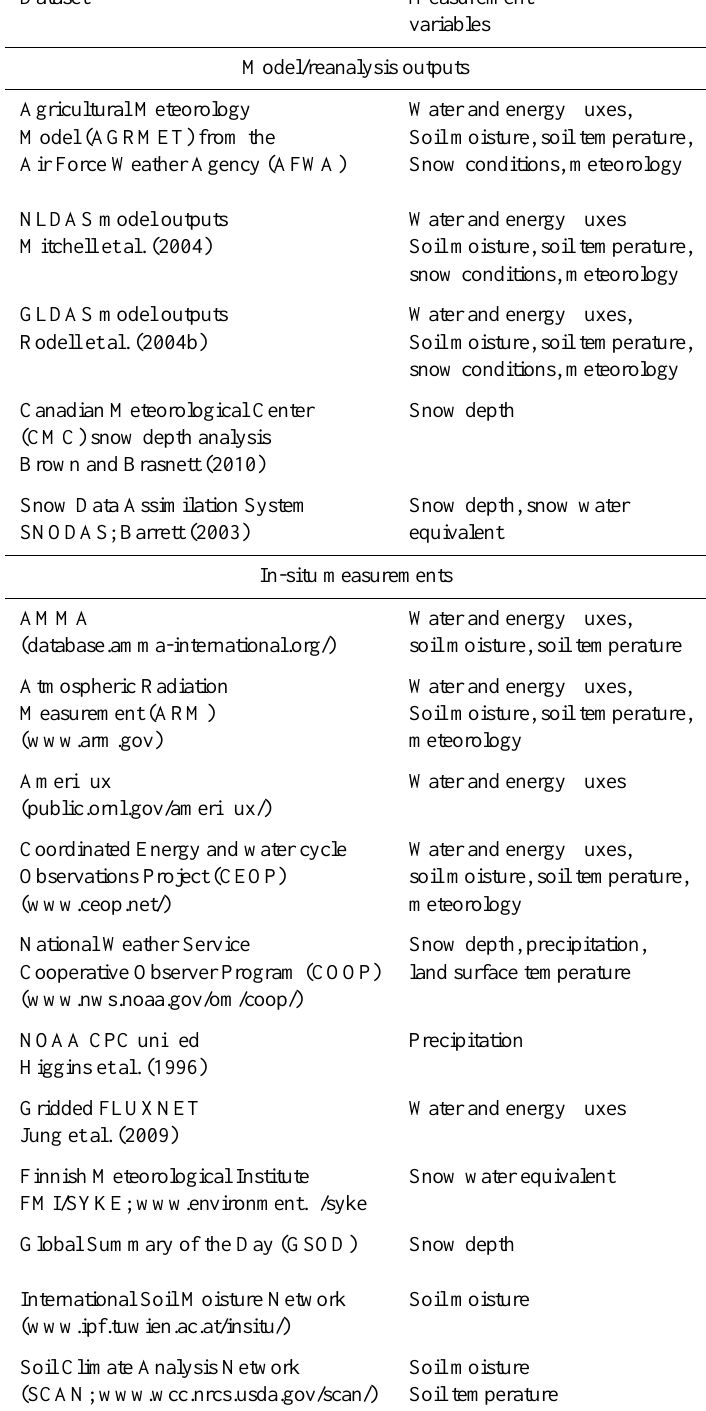
Table 1. List of datasets supported in